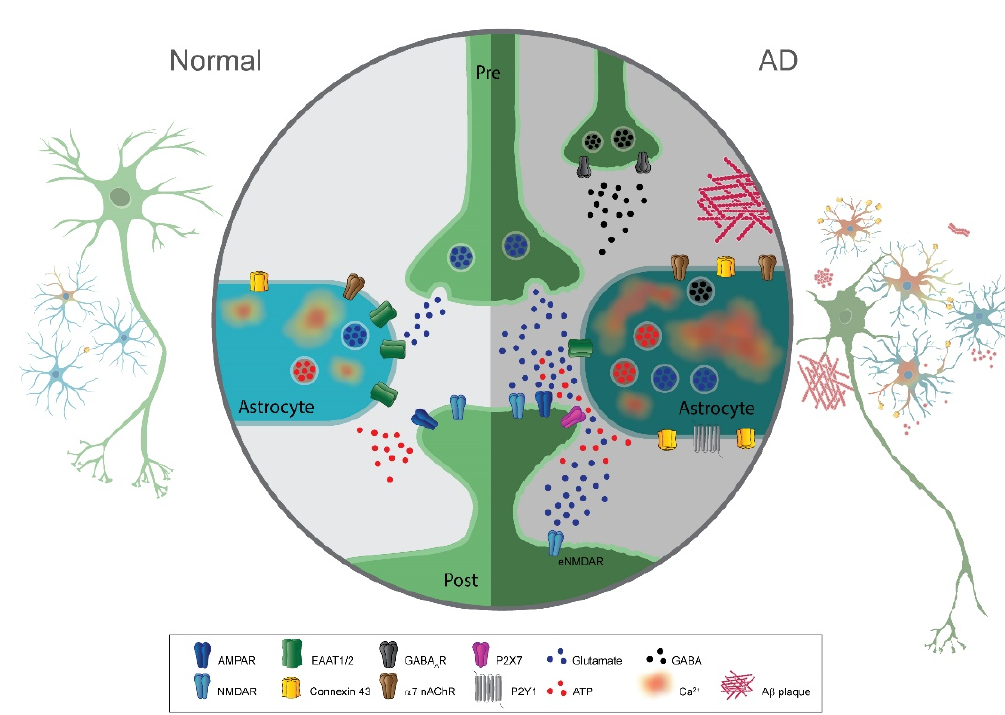
Figure 4. Summary of astrocyte–neuron communication alterations in Alzheimer´s disease. Representation of an astrocytic and neuronal network in the normal state ( left ) and during the pathogenesis of AD ( right ). The magnification in the middle depicts a tripartite synapse in the normal state ( left ) and AD ( right ). Neurons are colored in green and astrocytes are colored in blue. Spontaneous astrocytic calcium signals are augmented in AD. The increase in calcium activity has been suggested to be mediated through upregulation of the purinergic receptor P2Y1, α 7 nAChR, and/or the metabotropic glutamate receptor mGluR5 in astrocytes. Elevations in astrocytic intracellular calcium concentration promote the up-regulation of Cx43, leading to enhanced release of gliotransmitters (glutamate, ATP, and GABA). Diseased astrocytes express lower amounts of the glutamate transporter EAAT2 (or GLT-1), contributing to the accumulation of glutamate in the synaptic cleft. The increase in glutamate and ATP will overstimulate ionotropic receptors with consequent neuronal death. Thus, the presence of A β and the malfunctioning of astrocytes in AD lead to impairments in the neuronal network, decreasing the density of synaptic puncta and the basal synaptic transmission, which in turn will produce impairments in learning and memory. AD: Alzheimer ´ s disease; α 7 nAChR: α 7 nicotinic acetylcholine receptors; Cx43: connexin 43; eNMDAR: extra-synaptic NMDA receptor.